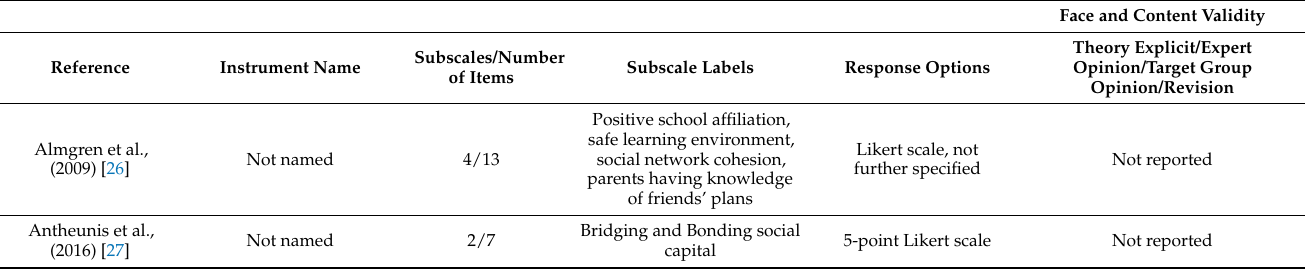
Table 4. Instrument characteristics and face and content validity (COSMIN step